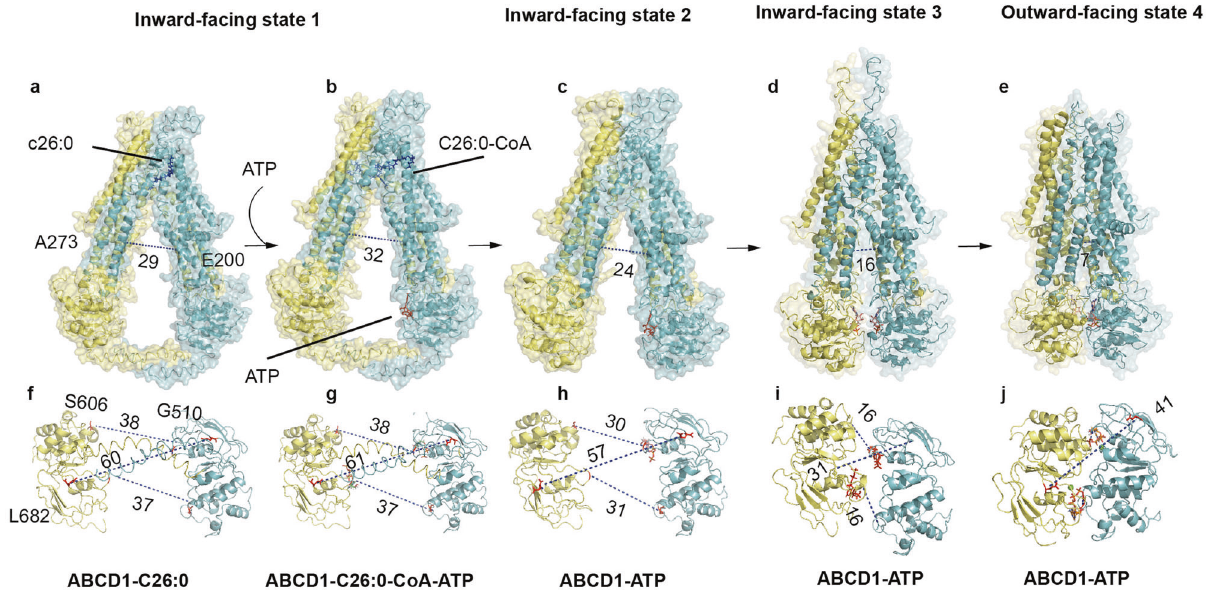
Fig. 5 Three inward-facing states and one outward-facing state of ABCD1. a , b Surface representation of ABCD1 in inward-facing state 1, characterized by the presence of C-terminal coil. c Structure of ABCD1 in inward-facing state 2, with a shortened distance of two NBDs compared with that in state 1. d ABCD1 with narrower vestibule opening to the cytosol when captured in inward-facing state 3. e ATP stapling the two NBDs and the outer segments of the TMD pealed open to the peroxisome lumen. f – j Measurement of the distance between the two NBDs based on the different states of ABCD1